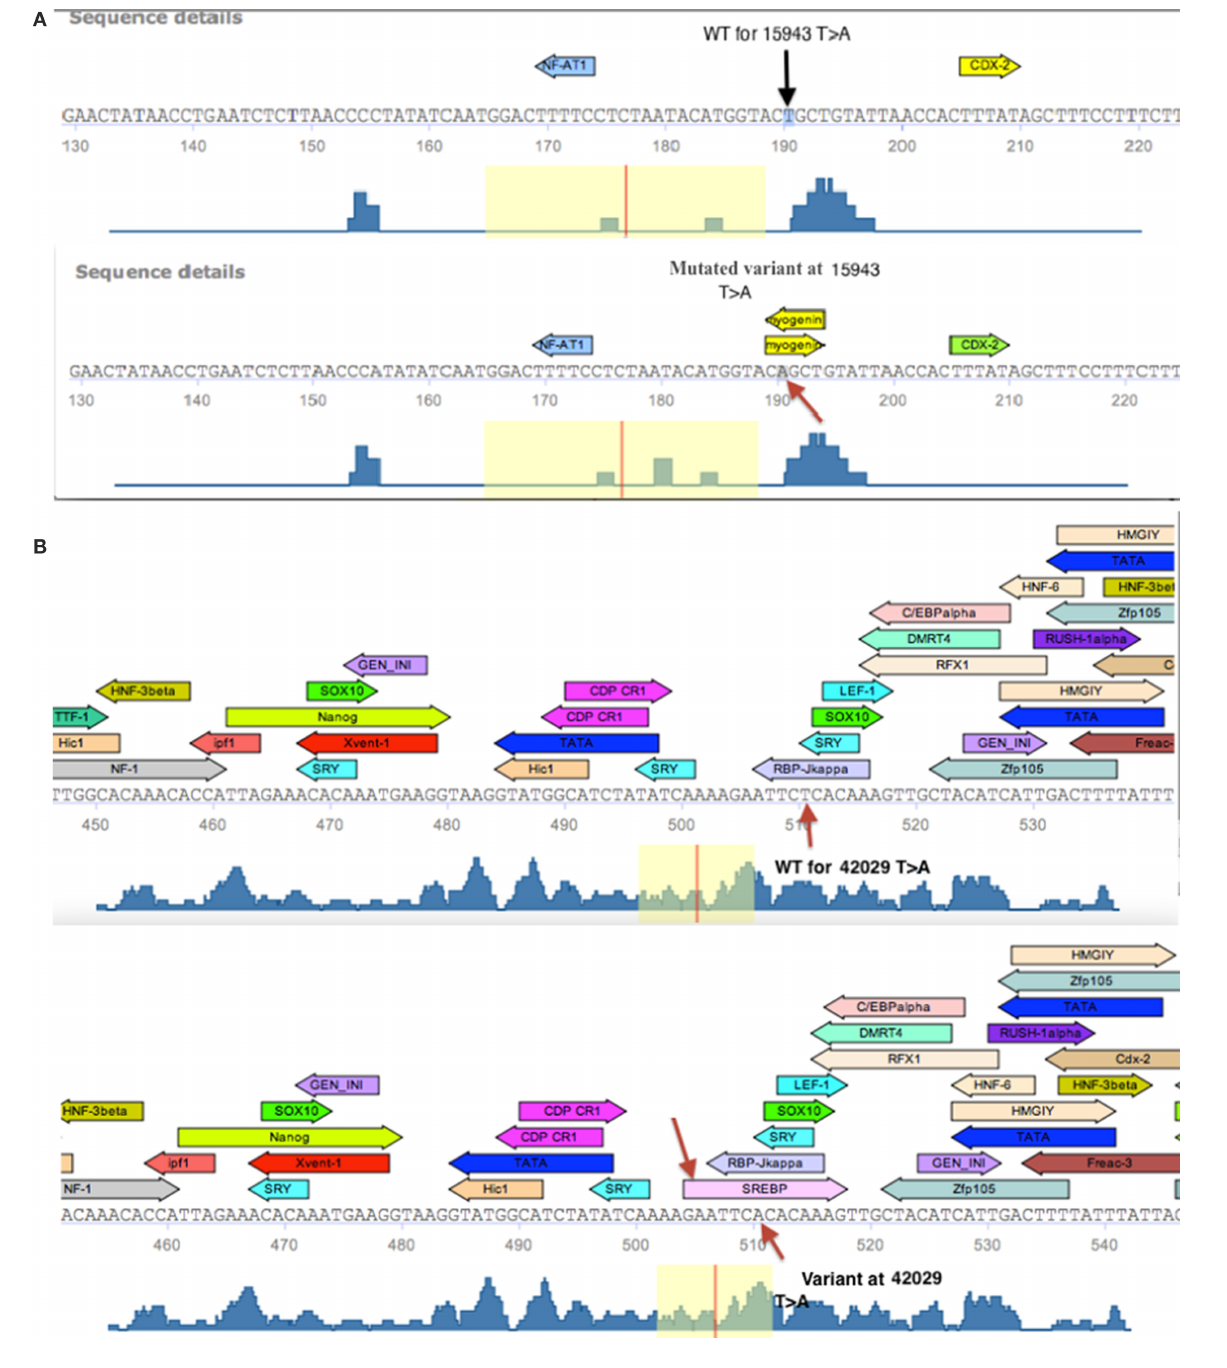
position 15943. (B) Diagram of the depicted SREBP TF binding site that is generated by the variant at 42029 (indicated by an arrow) at LATS1 intron-6 as well as the predicted TF binding sites that were interrupted by the variant (Kel et al., 2003; Matys et al., 2006).